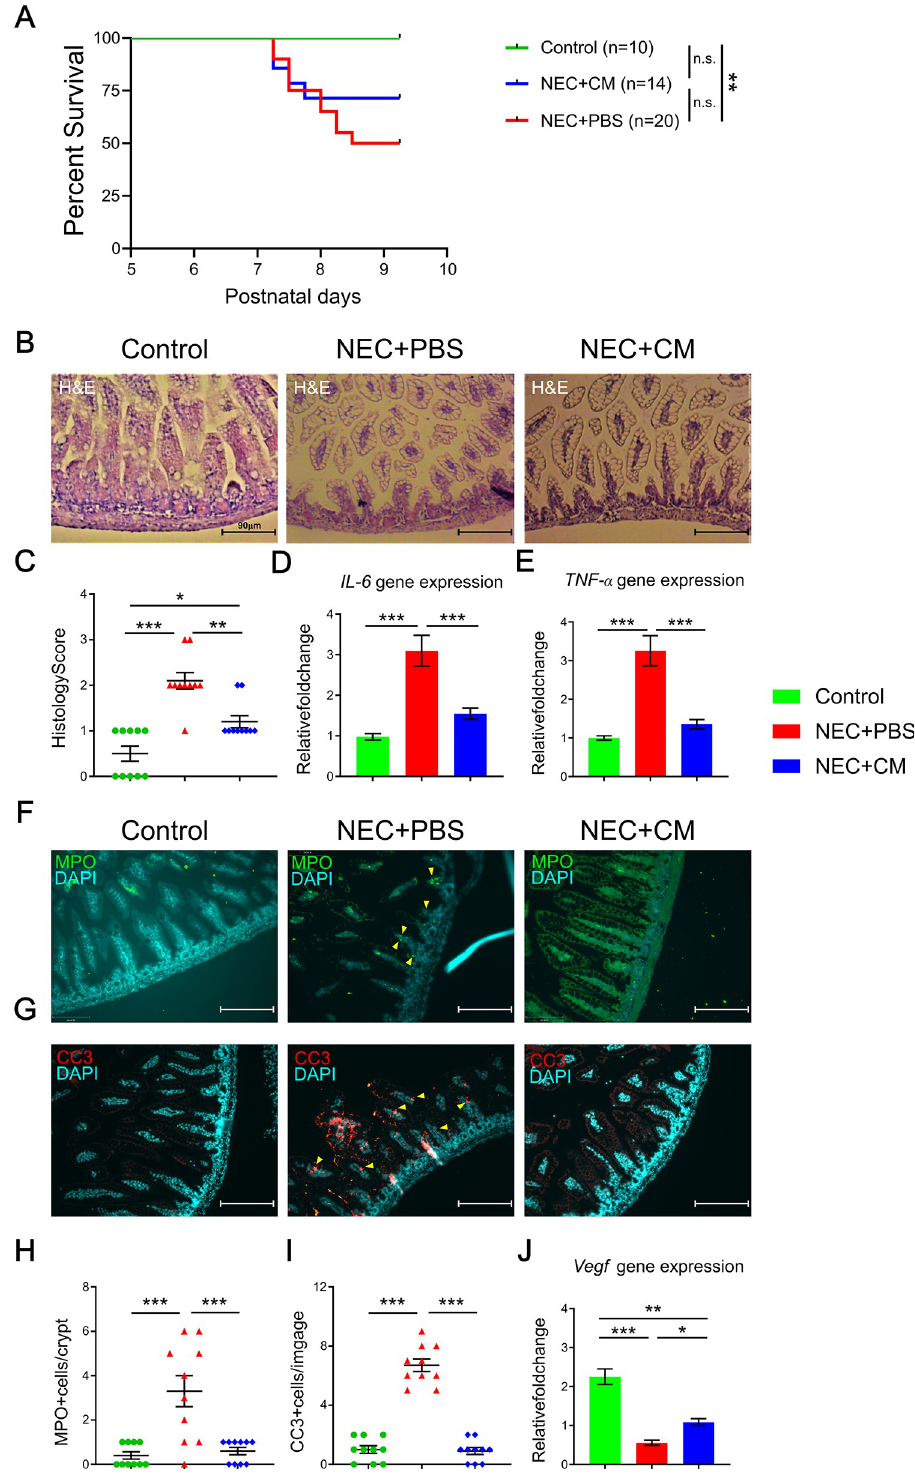
Fig 2. NEC survival and intestinal injury. (A) Survival curves for mice pups from the 3 groups on postnatal days 5 to 9. (B) Representative histological images of the terminal ileum. (C) Histological score of intestinal injury. Inflammatory gene marker expression of (D) Il-6 and (E) Tnf- α . Immunofluorescent protein expression of (F) MPO and (G) CC3 in the terminal ilea of the 3 groups. Yellow arrows indicate positive staining. Relative quantification of